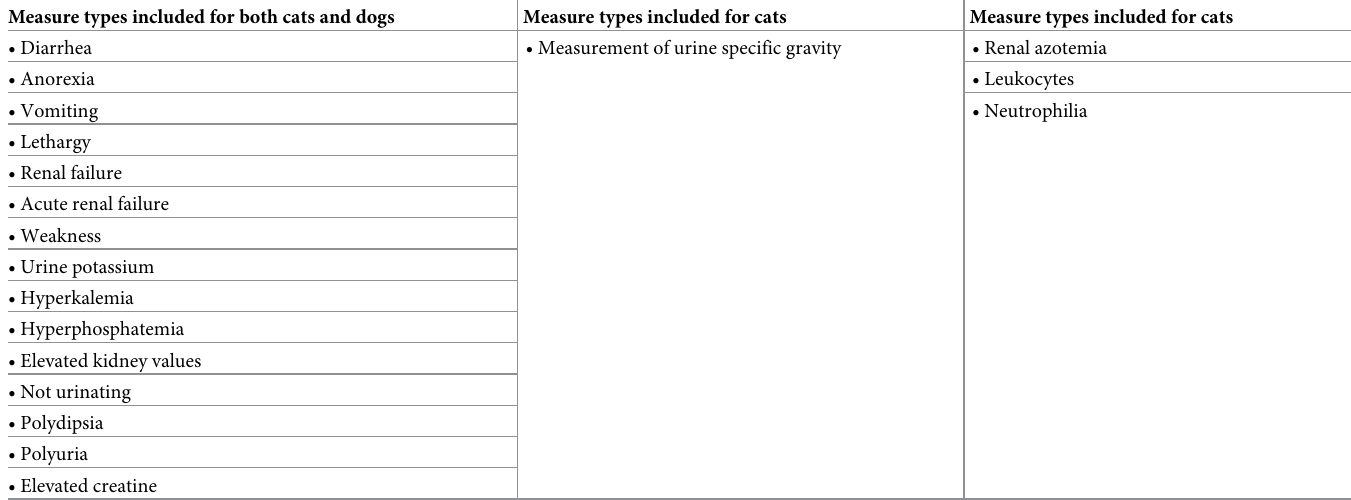
Note: MCTS syndromic components were chosen based on documented clinical signs and laboratory findings associated with dog and cat exposures to toxic amounts of melamine and cyanuric acid [9, 28, 30, 31]. Although some of these measure types may represent aggregate outcomes, for example, renal azotemia corresponds to elevated kidney values specifically blood urea nitrogen and creatinine, these measures were categorized by APCC staff during the call and these pre-classified measures were used for